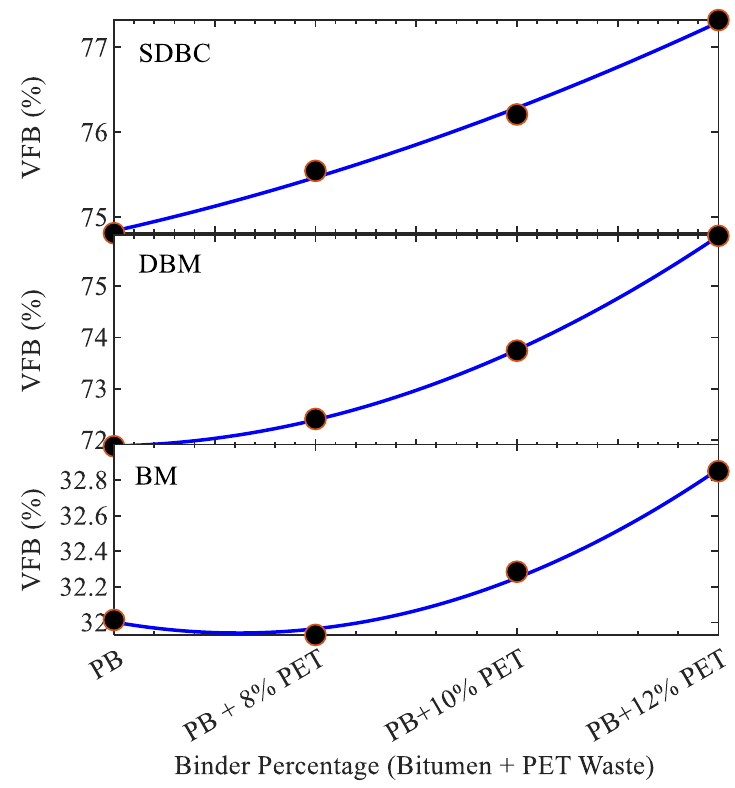
Fig. 28 Relations between voids filled with bitumen and binder content for modified SDBC, DBM, and